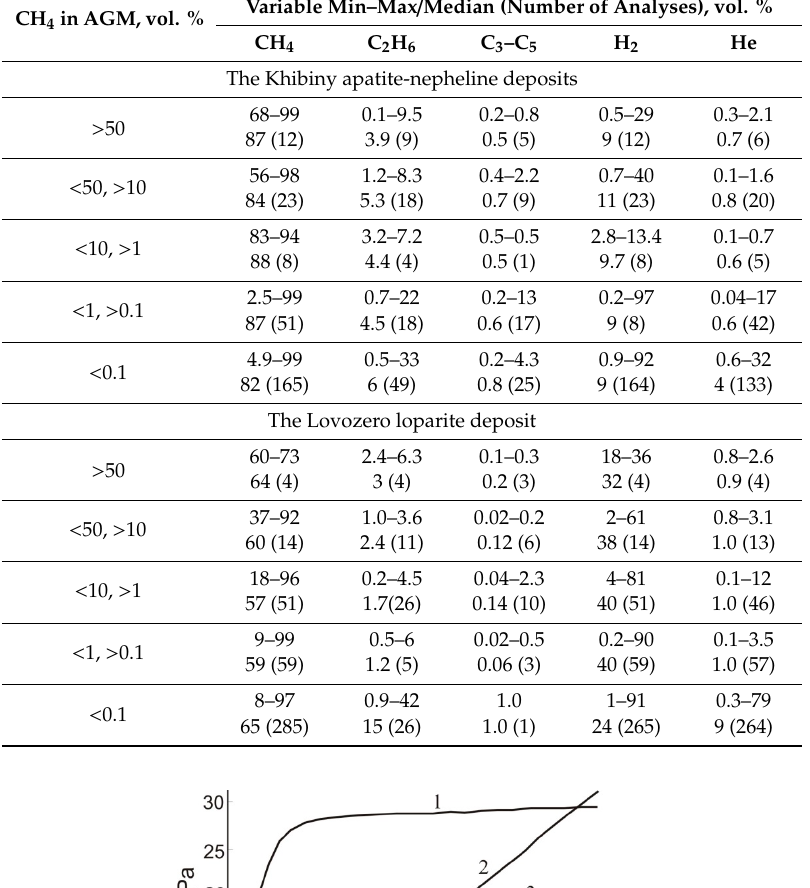
Table 4. Composition of free gases calculated as an air-free mix of continuously present components on the basis of the degree of dilution with atmospheric air–C Н 4 concentrations in the air–gas mix (AGM).